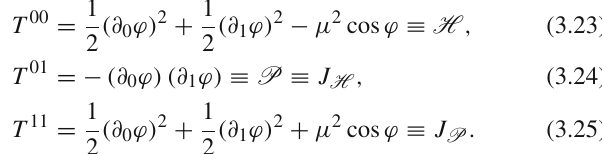
In the case of the static seed, only when E > μ 2 all kinks propagating on the elliptic background are subluminal. When E < μ 2 , there is always a range of ˜ a which gives rise to superluminal